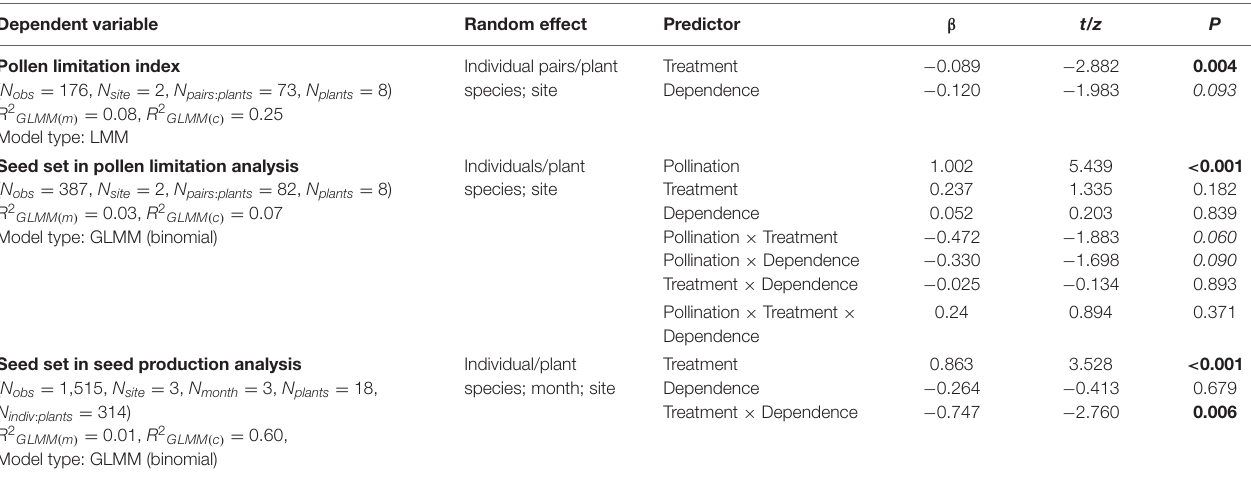
TABLE 1B | GLMMs with binomial distributions explaining the effects of treatment (grazed versus ungrazed), pollination (open pollination versus supplemental pollination), and pollinator dependence (high dependence versus low dependence) on seed set of plants. Dependent variable Random effect